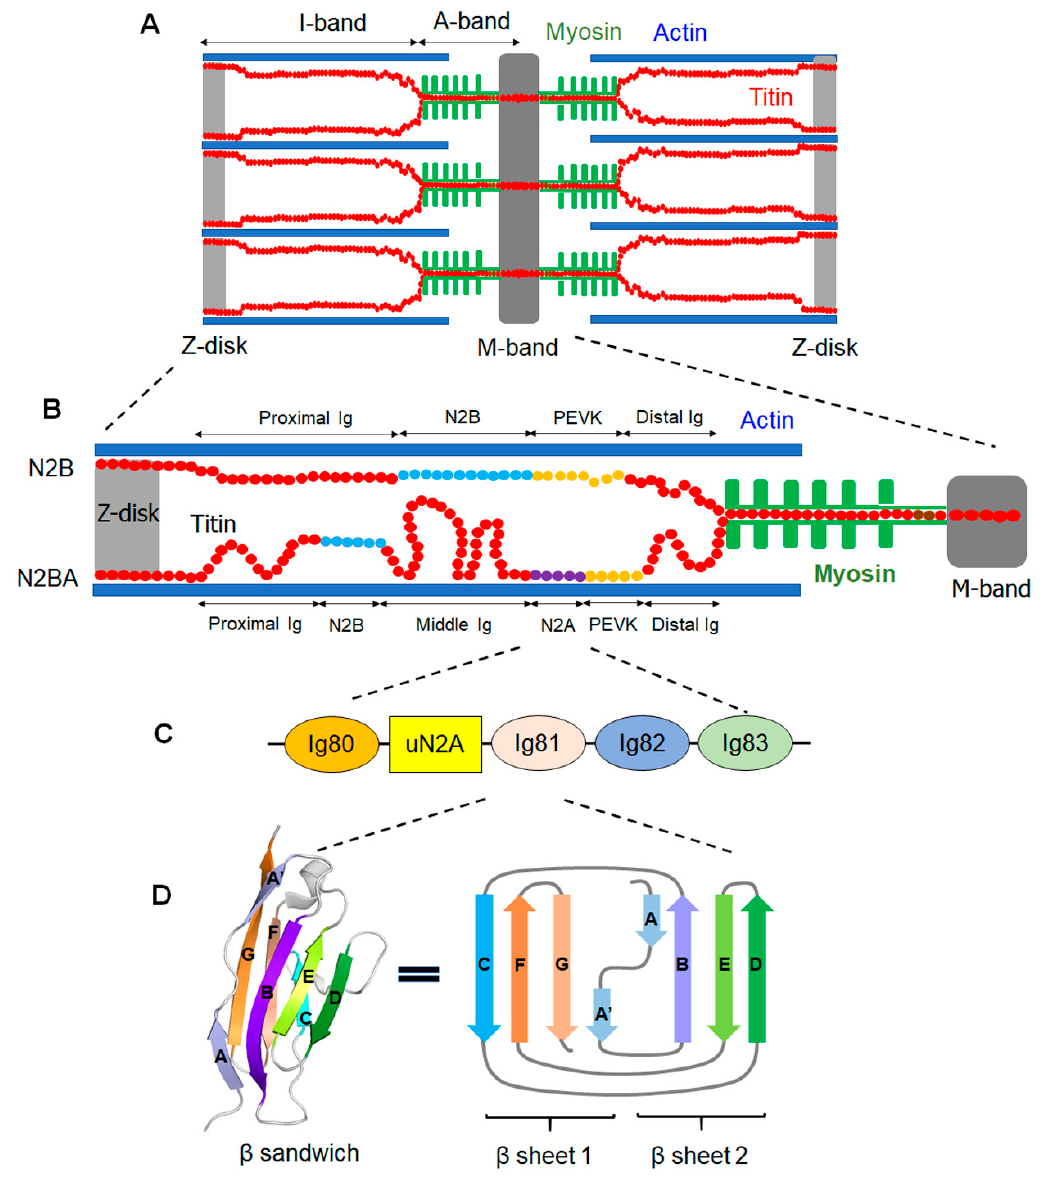
Figure 1. Structural organization of sarcomere, titin, and the N2A insertion of titin. ( A ) General depiction of the sarcomere in striated muscle showing the Z-disk demarcation of each sarcomere and the M-band in the middle of the sarcomere. The I-band and A-band sections of the sarcomere are indicated. The myofilament proteins, myosin (thick filament, green), actin (thin filament, blue), and titin (red), are shown. ( B ) Schematic representation of titin in striated cardiac muscle with a depiction of the N2B and N2BA isoforms in the half sarcomere. The N2BA isoform has additional segments, namely the middle immunoglobulins (Ig) and the N2A insertion. ( C ) Structural domains of the N2A insertion of titin. The N2A insertion has five sub-domains, among which four are immunoglobulin-like (Ig80, Ig81, Ig82, and Ig83) and one is a unique sequence (uN2A). ( D ) Crystal structure of the Ig81 sub-domain of N2A. The β -strands are aligned in an antiparallel orientation to form two groups of β -sheets, ABED and A’GFC. The β -sheets lie over each other in parallel to form a β -sandwich structure. ( A , B ) were adapted and redrawn from Koser et al.’s publication [4], and ( D ) was adapted and redrawn from Meyer and Wright’s publication [17].